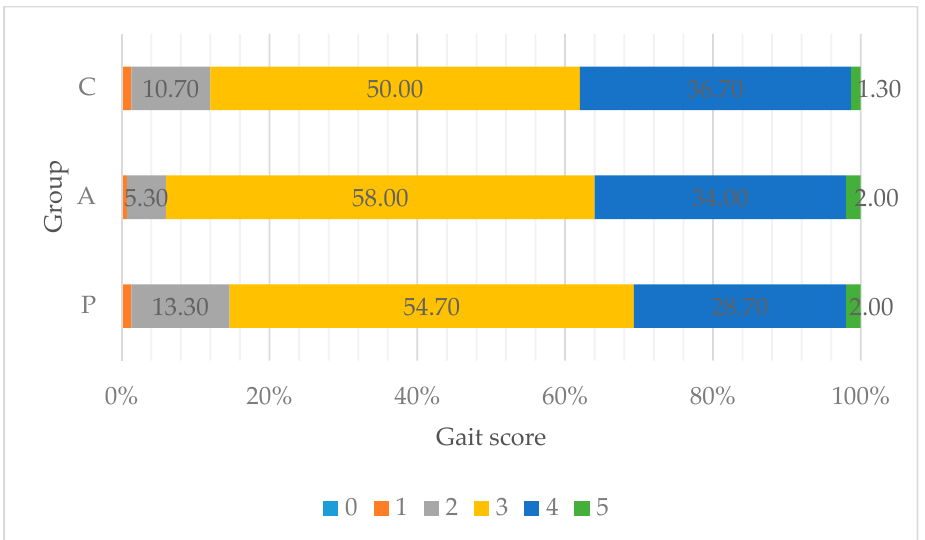
Figure 1. Assessment of walking ability in broiler chickens (%). The birds were fed a non-supple- mented control diet (C); the control diet supplemented (in addition) with a phytogenic supplement containing hop (A); or the control diet supplemented with organic acids and their salts and prebiotic complex mixed in the proportion of 65/30 v/v , respectively (P). A gait score of 0 indicated the best walking ability, whereas 5 indicated the worst walking ability (a detailed description of respective gait scores can be found in the Materials and Methods section). The variation between groups did not differ significantly ( p = 0.346). For the studied groups, the median was 3, which means that over half of the birds were evaluated as 3. Mean + SD: C = 3.26 ± 0.718; A = 3.31 ± 0.636; P = 3.17 ± 0.730. A total of 30 birds from each replicate ( n = 5) was evaluated.